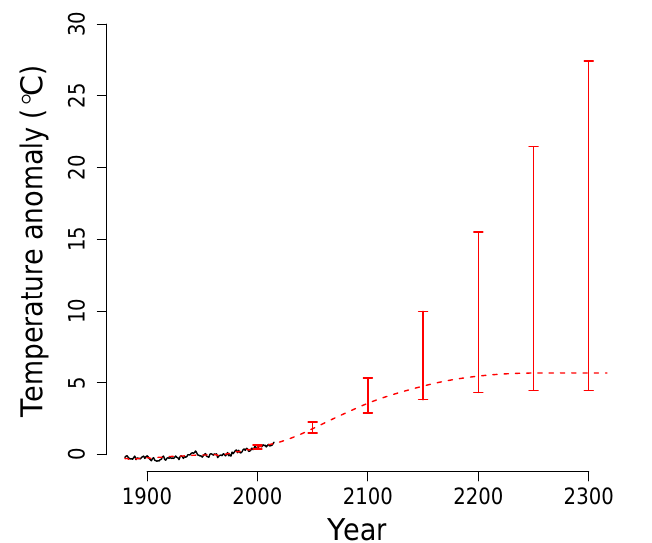
Figure 5. Projected mean temperature anomalies, and their un- certainties, under the RCP8.5 scenario, based on estimates from model (4) and assuming ARMA(4,1) noise. The black curve shows the observed temperatures. Intervals are pointwise (2.5–97.5)th per- centile intervals. Radiative forcing stabilizes in the year 2250, but mean temperatures and especially their uncertainties continue to increase. While uncertainties in the long-term response are quite large, due largely to the inability to rule out implausible values of λ A , the historical and near-term response is much more